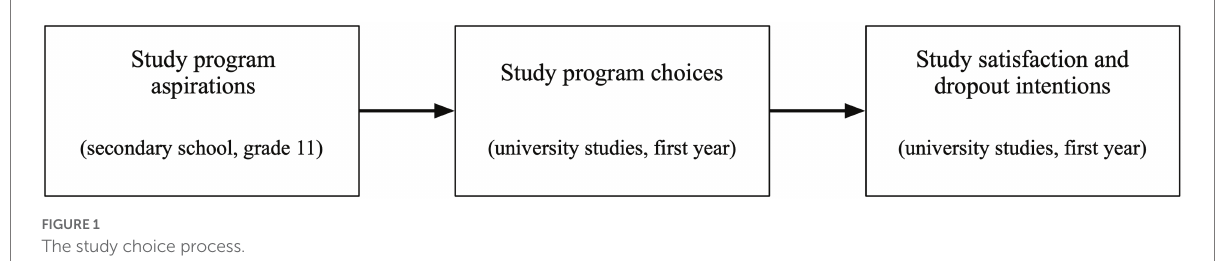
FIGURE 1 The study choice